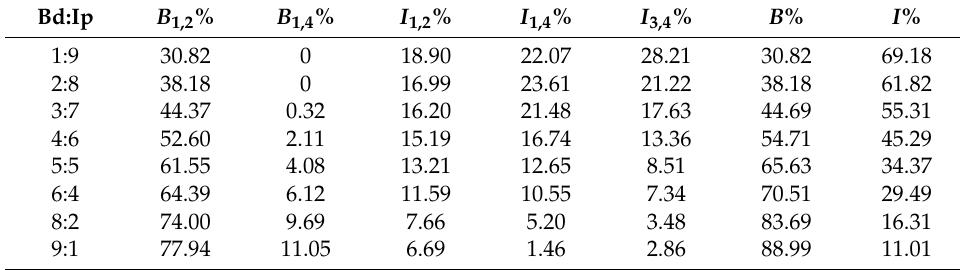
Table 5. Effect of different Bd/Ip mole ratios from 1:9 to 9:1 on the microstructures of the resulting copolymers.